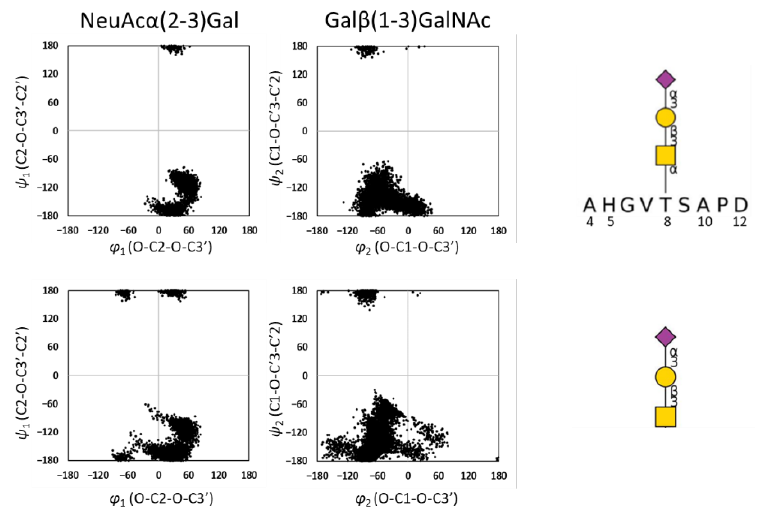
Figure 5. Distribution of dihedral angles of O -glycan in MUC1 obtained by MD simulation. O -glycan presented on MUC1 peptide ( top ) and O -glycan alone ( below ) were simulated.